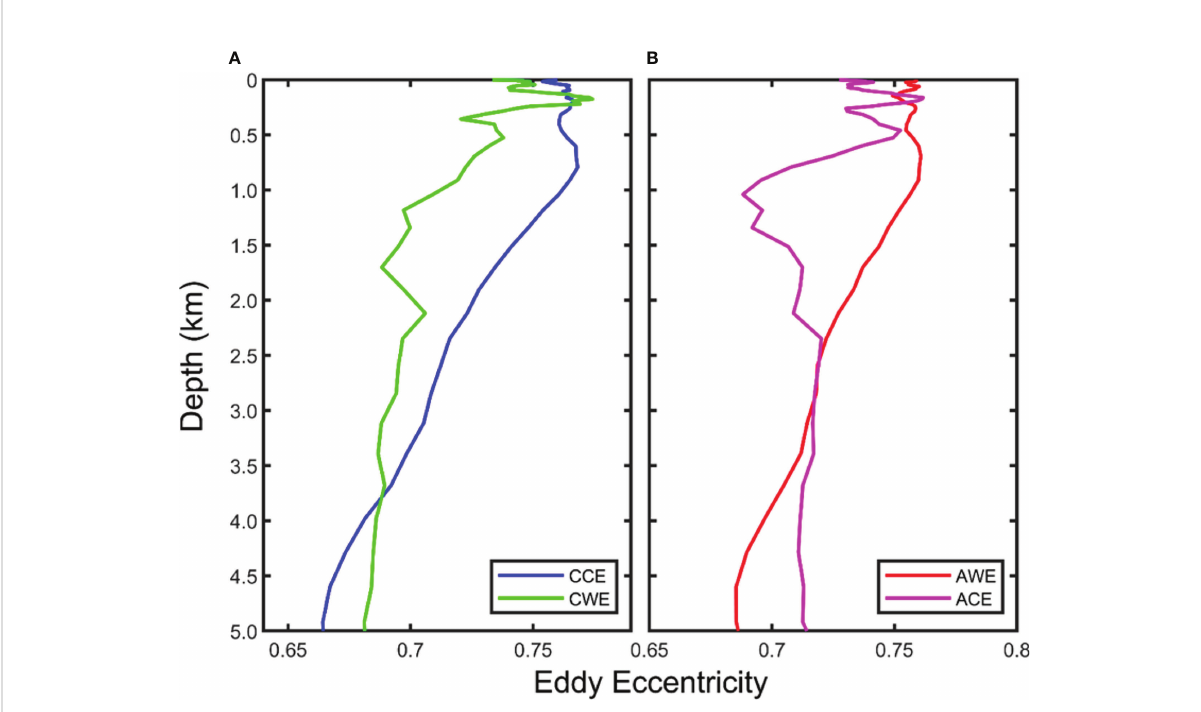
FIGURE 9 Vertical distribution of the average eddy eccentricity of the four types of eddies in the STCC region. Blue, red, green, and magenta curves represent cyclonic cold-core eddy (A) , anticyclonic warm-core eddy (B) , cyclonic warm-core eddy (A) , and anticyclonic cold-core eddy (B) ,